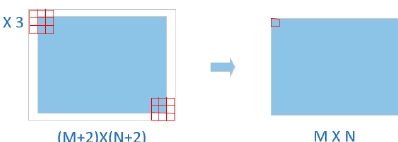
Figure 3. The process of padding. The size of the input image is (M × N) . After padding(pad=1), the image size becomes (M + 2) × (N + 2) .